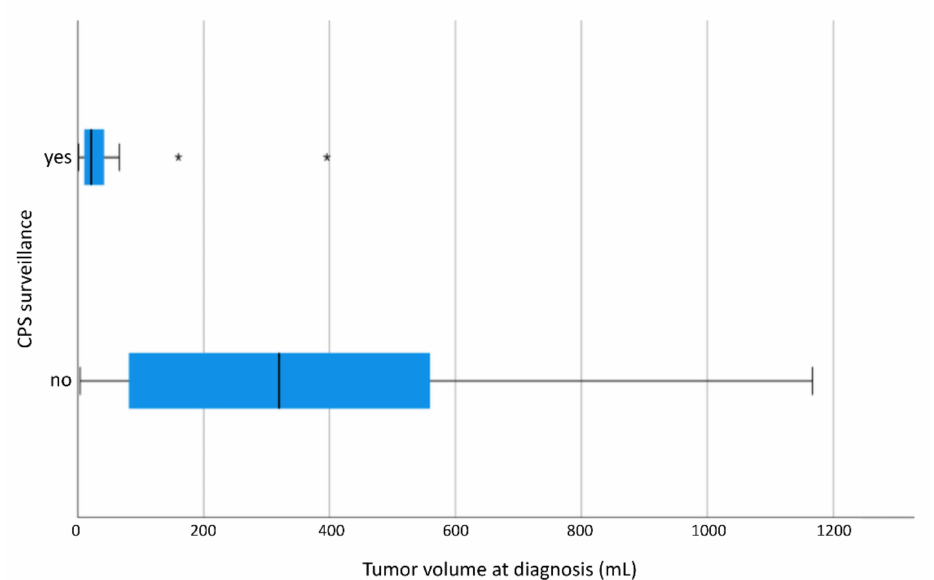
Figure 2. TV at diagnosis of CPS patients as a function of CPS surveillance displayed as a boxplot. TV at diagnosis of 17 patients with CPS surveillance and of 101 patients without CPS surveillance. 2 outliers in patients with CPS surveillance at 160.0 mL and 396.0 mL and 3 outliers in patients without CPS surveillance at 1631.0 mL, 1632.0 mL and 2051.0 mL. CPS patients with CPS surveillance show significantly smaller TV at diagnosis ( p < 0.001). “*”: outliers; CPS: cancer predisposition